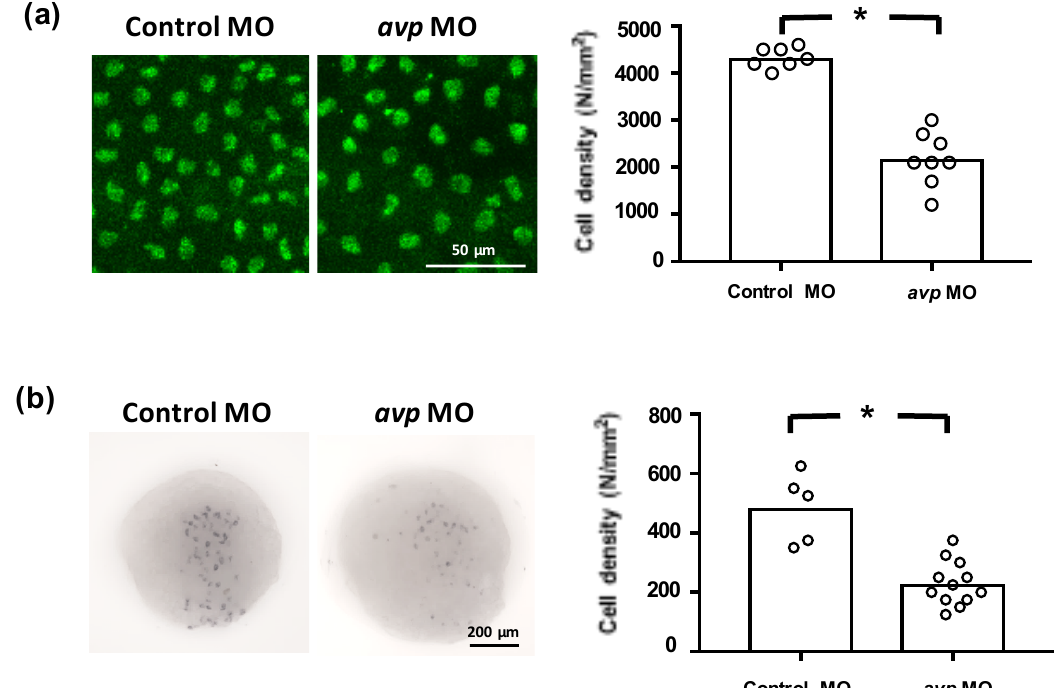
Figure 6. E ff ects of morpholino-mediated downregulation of AVP on ionocyte precursor cell density. Epithelial stem cells at 3 dpf ( a ) and ionocyte progenitors at the tail-bud stage ( b ) were labeled by p63 antibody and foxi3a antisense riboprobe, respectively. Mean cell densities of p63- or foxi3a -expressing cells are indicated by bars with individual values shown as white-filled circles. Values are means ( n = 5–12). Asterisks indicate a significant di ff erence from control group, according to Student’s t -test, p <